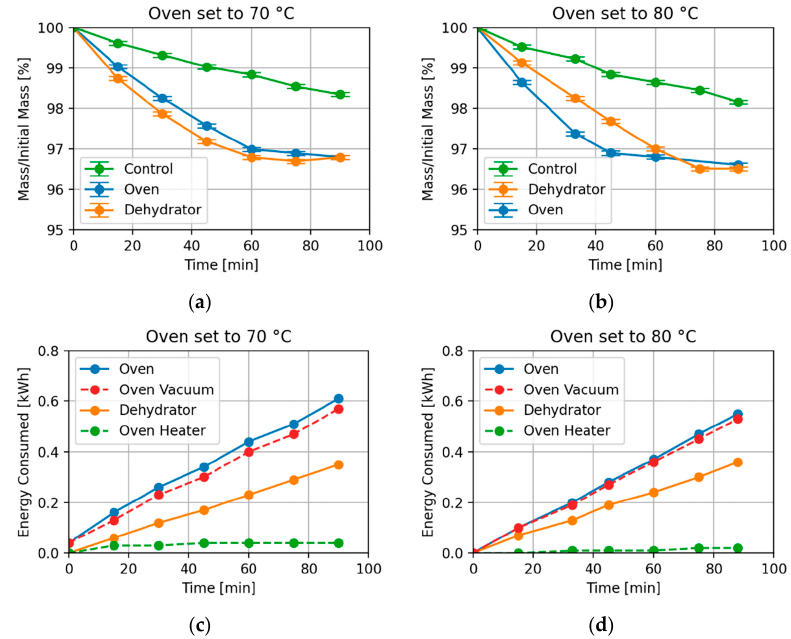
Figure 20. Dehydration measurements on small (10 g) samples of rPET. Increasing the oven temperature from 70 (left) to 80 °C (right) caused a 40% decrease in drying time. ( a ) Sample percent initial mass with the vacuum oven set to 70 °C. The vacuum oven was 25% slower than the dehydrator at this setting; ( b ) Sample percent initial mass with the vacuum oven set to 80 °C. In this case, the vacuum oven was 40% faster than the dehydrator. ( c ) The energy consumed during the 70 °C test. The dashed lines are summed in the blue aggregate energy for the oven. ( d ) The energy consumed during the 80 °C test.